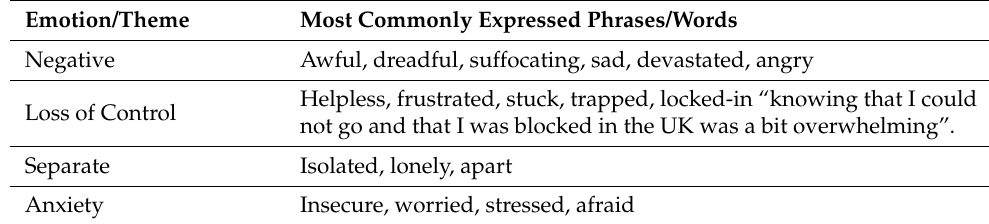
Table 2. Emotions Felt Due to Restricted VFR